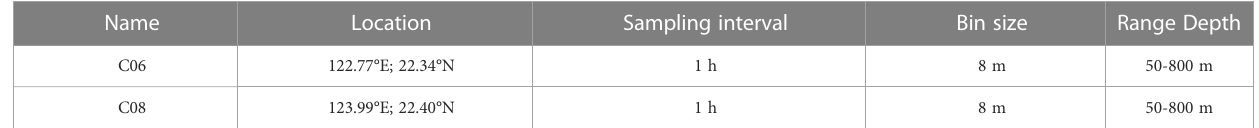
TABLE 1 Mooring deployment